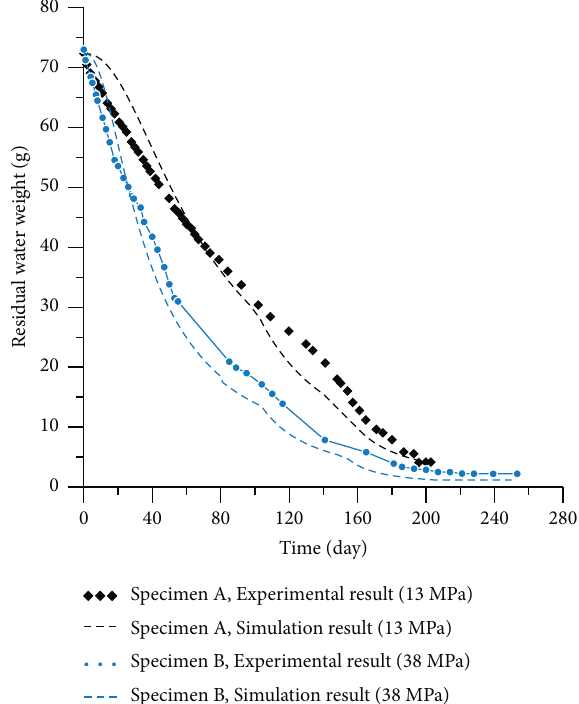
Figure 7: Comparison of experimental results and simulation results: changes in residual water